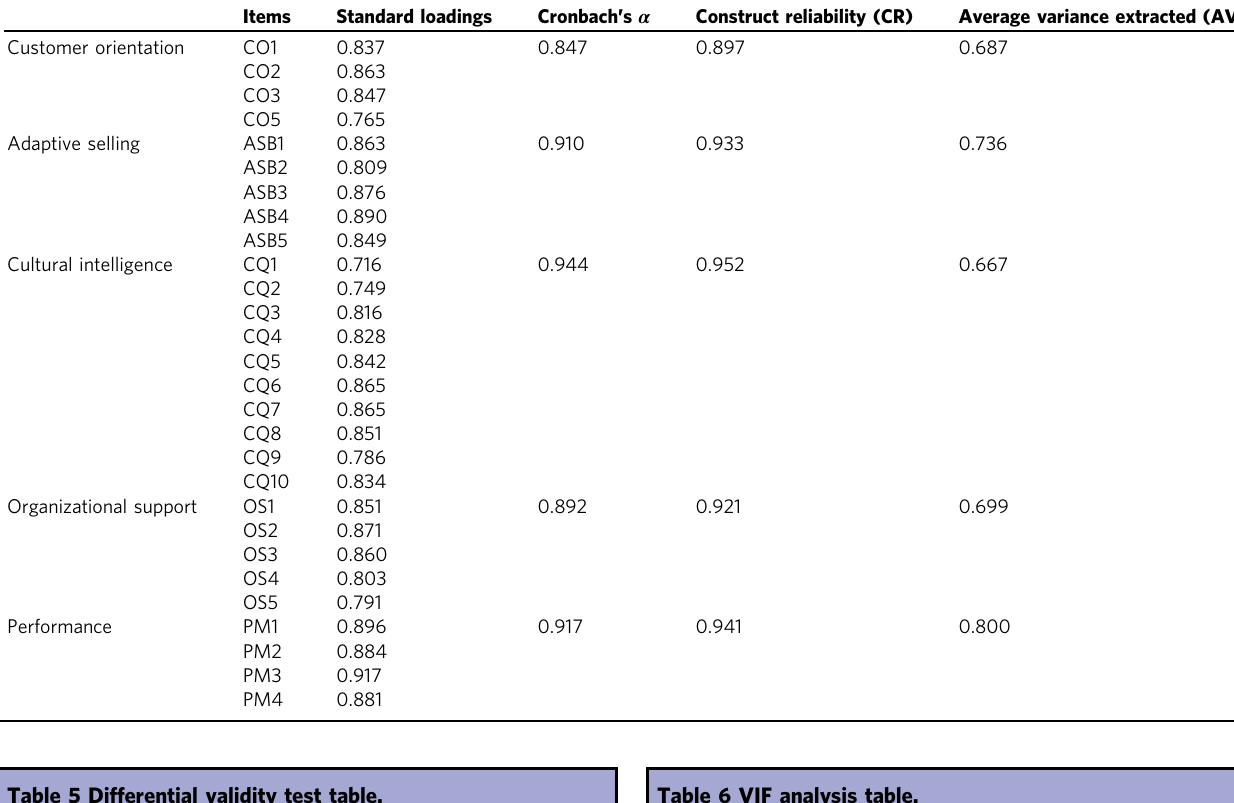
Table 4 Measurement model parameter estimation table.